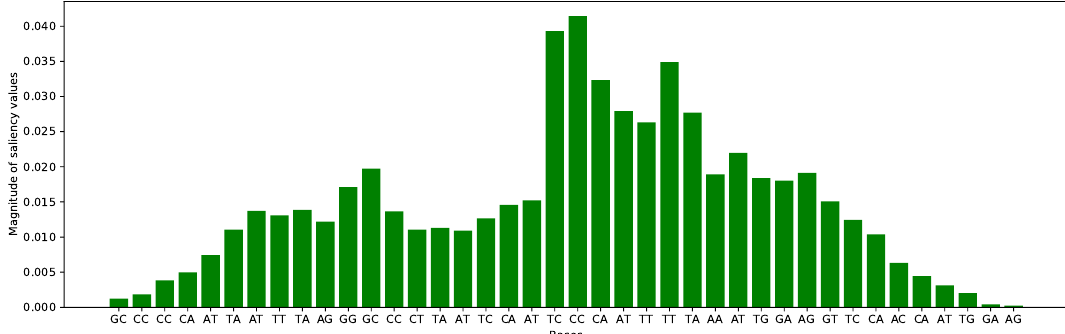
Figure 12. Saliency map of each di-nucleotide influence on model’s output in the Fragaria Vesca